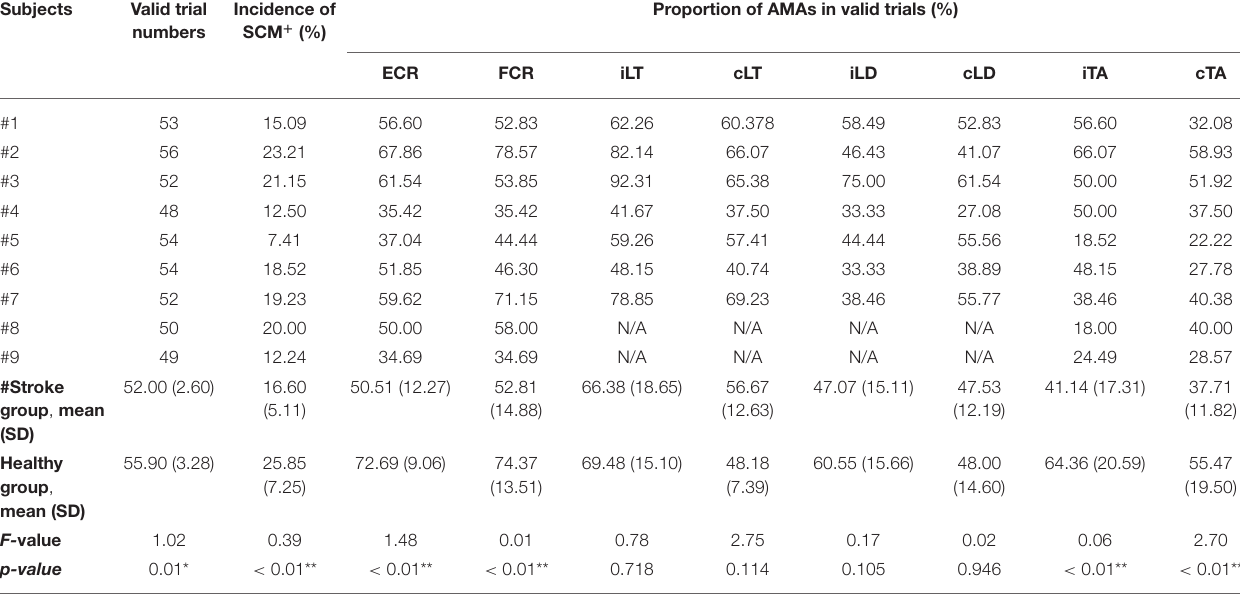
TABLE 3 | Proportion of startle responses and anticipatory muscle activations (AMAs) of subjects.